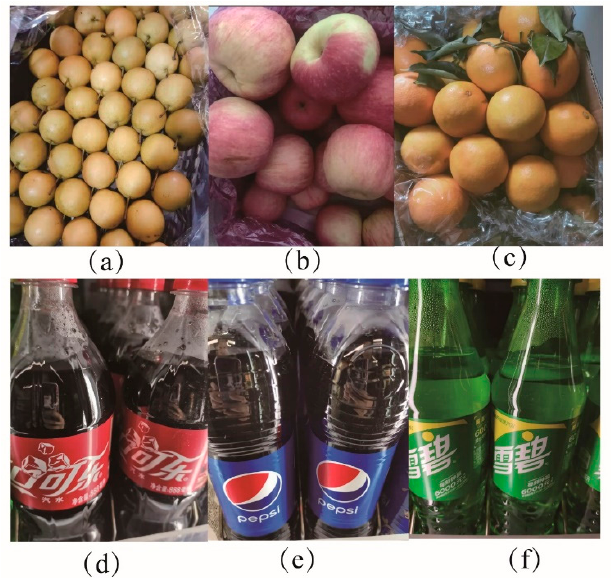
Figure 1. The sweet drink materials tested in this work. ( a ) pears; ( b ) apple; ( c ) oranges; ( d ) Coca-Cola; ( e ) Pepsi; ( f ) Sprite.